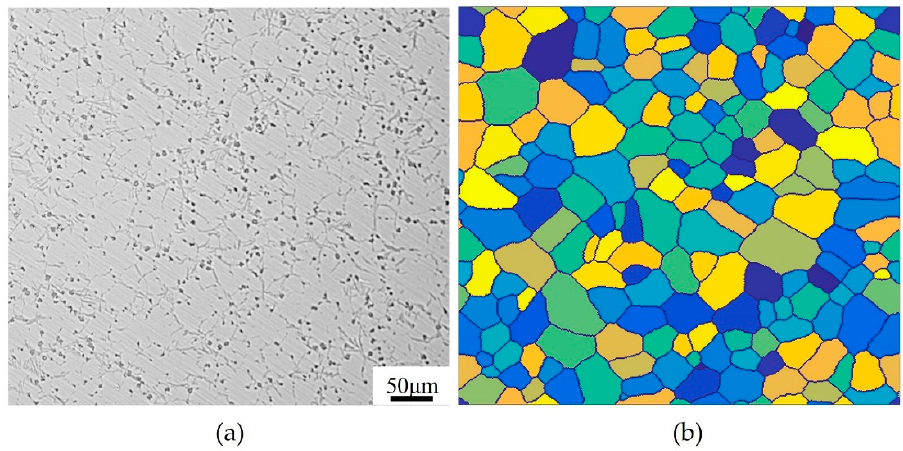
Figure 4. The initial microstructure of ( a ) the actual sample and ( b ) the CA model. During simulation, there are four state variables for each cell in the CA model, which are the grain orientation variable; dislocation density variable; grain boundary recognition variable and recrystallization recognition variable, respectively. The grain orientation variable is used to distinguish different grains and grain boundary energy. Each cell is randomly assigned an orientation angle within the range of 0–180 ◦ , and the adjacent cells with the same orientation angle are classified as one grain; the dislocation density variable may record the varication of dislocation density in grains with strain and the deformation stored energy; the grain boundary variable can recognize whether cells are located at grain boundaries; the recrystallization variable can recognize the formation and proportion of R -grains. In addition, the influence of carbides on the CA model is not considered in this